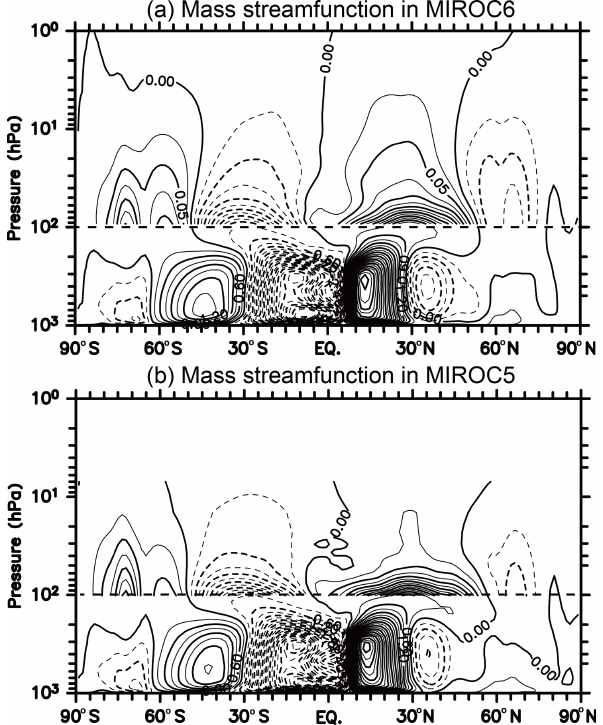
Figure 9. Annual mean mass streamfunctions in (a) MIROC6 and (b) MIROC5. Contour interval is 0 . 3 ( 0 . 025 ) × 10 10 kgs − 1 below (above) the 100hPa pressure level. Negative values are denoted by dashed contours, and the horizontal dashed lines indicate the 100hPa pressure